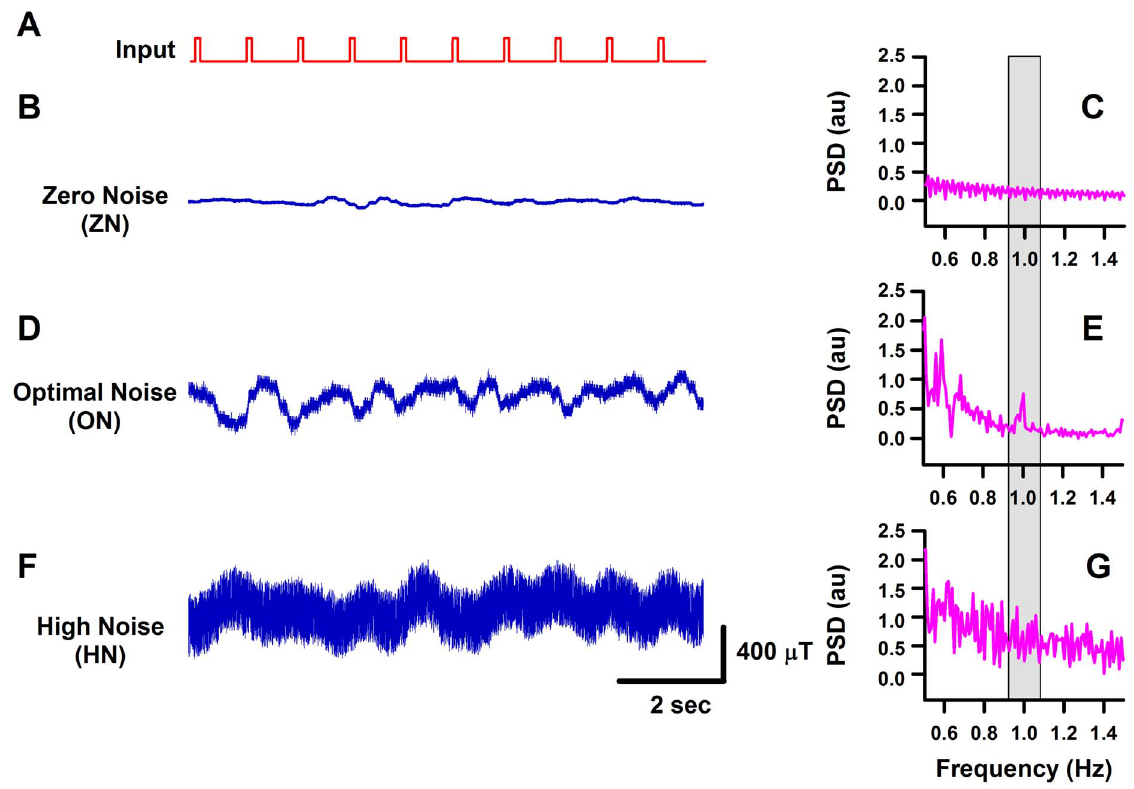
Figure 6. Recordings of continuous MEMS magnetic flux density and their corresponding power spectrum density. A , applied subthreshold magnetic stimulus (input). B, D and F , recordings of the detected MEMS magnetic flux density at three noise levels: zero, optimal, and high noise. Note that the probability to detect a signal is increased when an optimal level of magnetic noise was added. C, E and G , corresponding power spectrum densities (PSD) for the MEMS recordings illustrated in the left panel. The power spectra of the MEMS show a peak at the input frequency (1 Hz) for optimal noise but not for zero or high noise. The gray rectangle in the PSD illustrates the frequency of the detected periodic magnetic signal in which there is a peak for the optimal noise